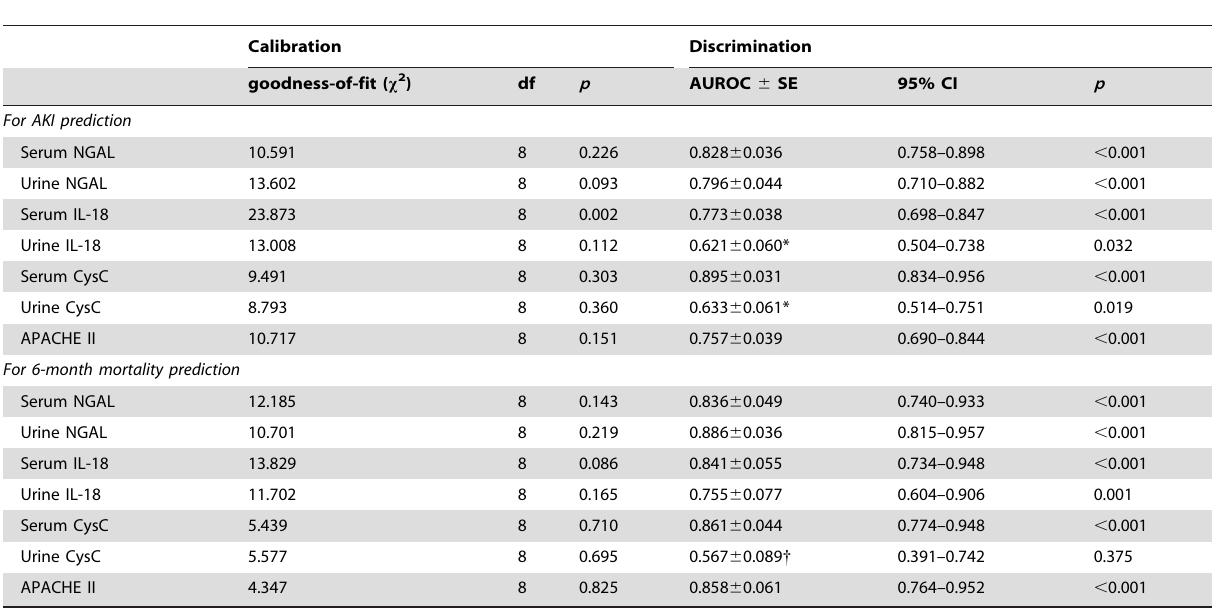
Table 2. Comparison of calibration and discrimination of the biomarkers and APACHE II on the first of CCU admission in predicting AKI and 6-month mortality.